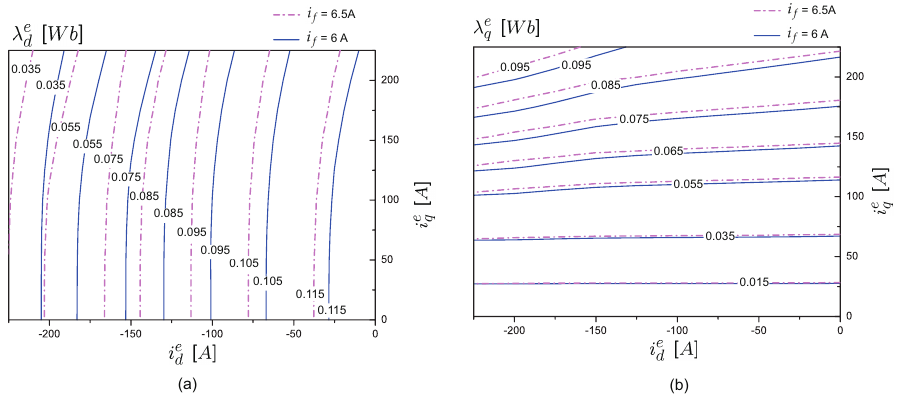
Figure 5. The Influence of the field current on dq -axes stator flux linkage ( λ e and ( b ) contour plot of λ e